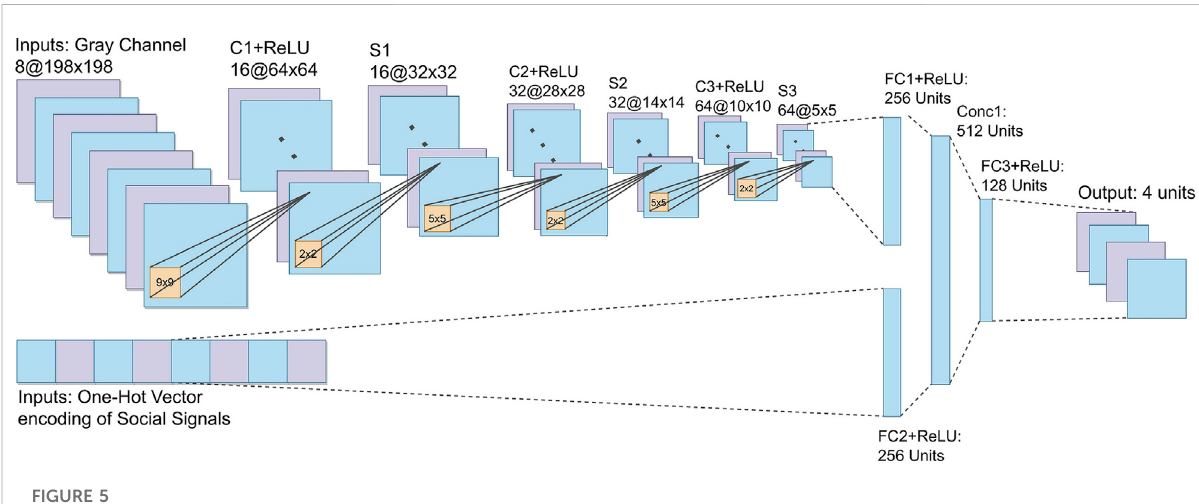
FIGURE 5 CNN of SocialDQN. The network classi fi es grayscale images and social signals in the environment interaction phase to generate action values. Eachoutputrepresentsanaction,andtheactionwiththehighestvalueisselected. Therearetwonetworksidentical totheoneintheimage,atarget network and another to be trained in the training phase. Examples of interactions stored in the Replay Buffer are used to evaluate each network, utilizing the reward values obtained in each interaction added to the outputs of the target network to adjust the weights of the main network. The Loss Function performs this adjustment. After n iterations, the target network updates its weights with the values of the main